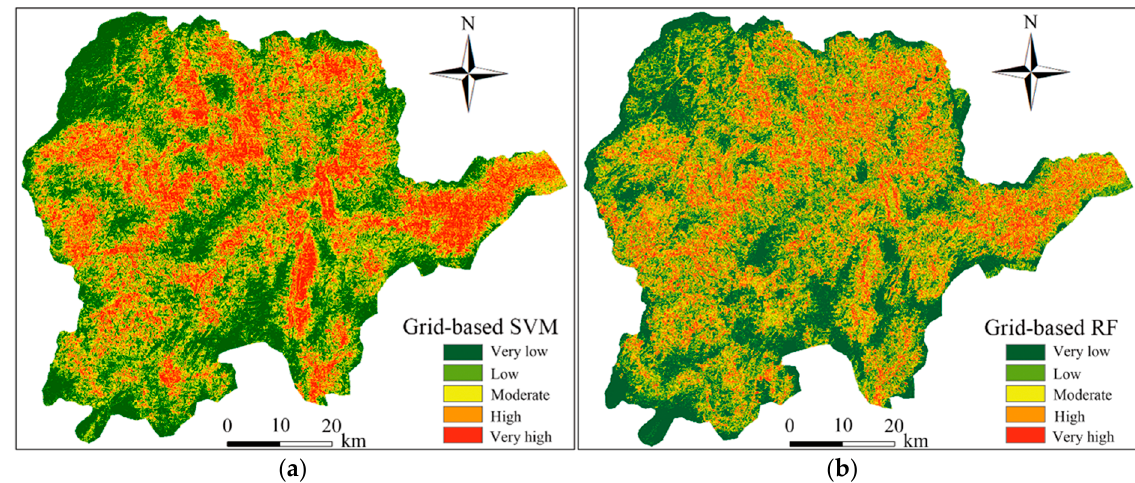
Figure 11. Landslide susceptibility map results using the grid units. ( a ) Grid-based SVM; ( b ) Grid- based RF.